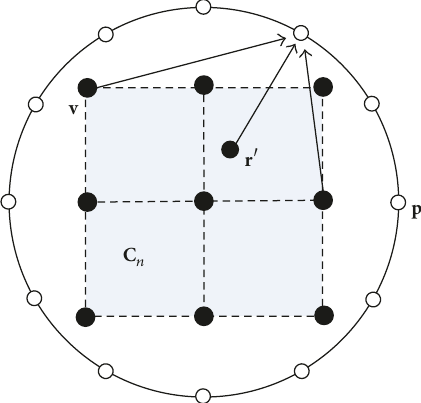
Figure 1: A 2D representation of the obtaining projection coeffi-